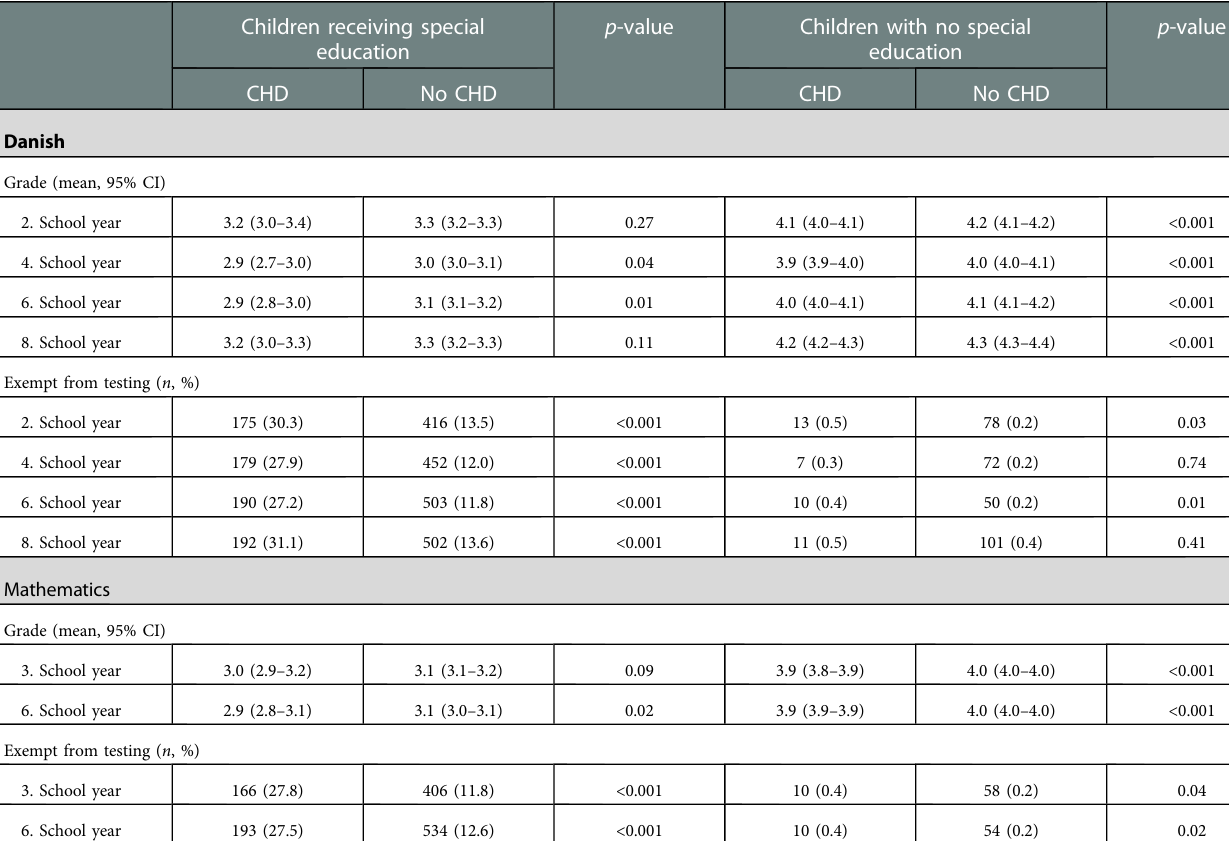
TABLE 4 Performance in the Danish national tests strati fi ed on the receival of special education.